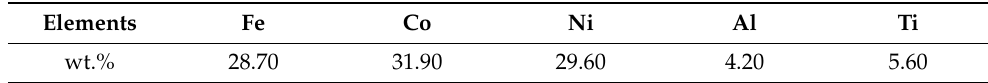
Table 1. Chemical composition of FeCoNiAlTi HEA powders.